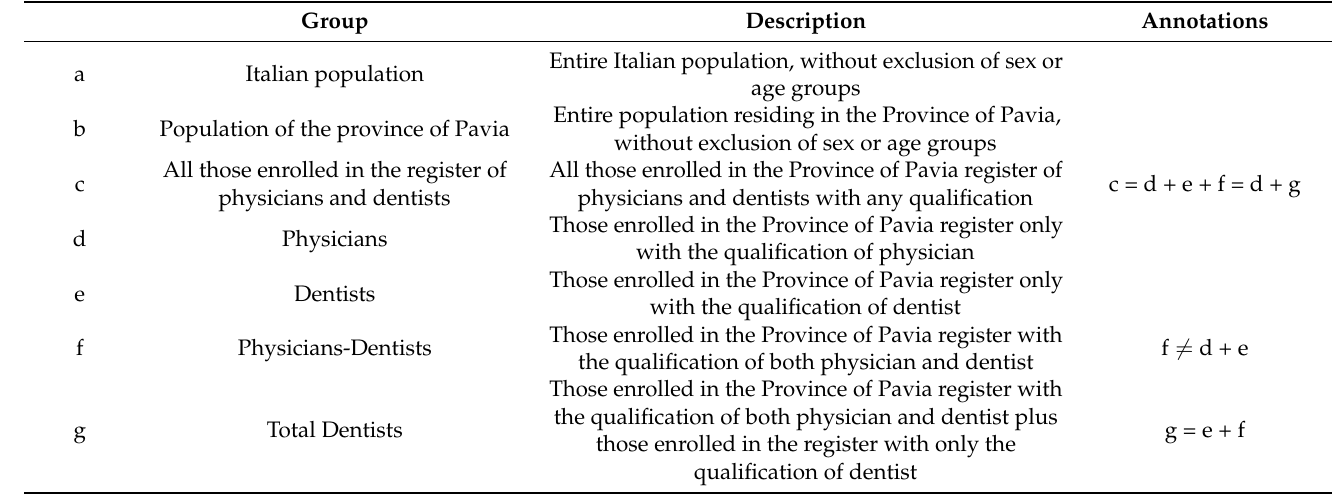
Table 1. Groups analyzed in the study.